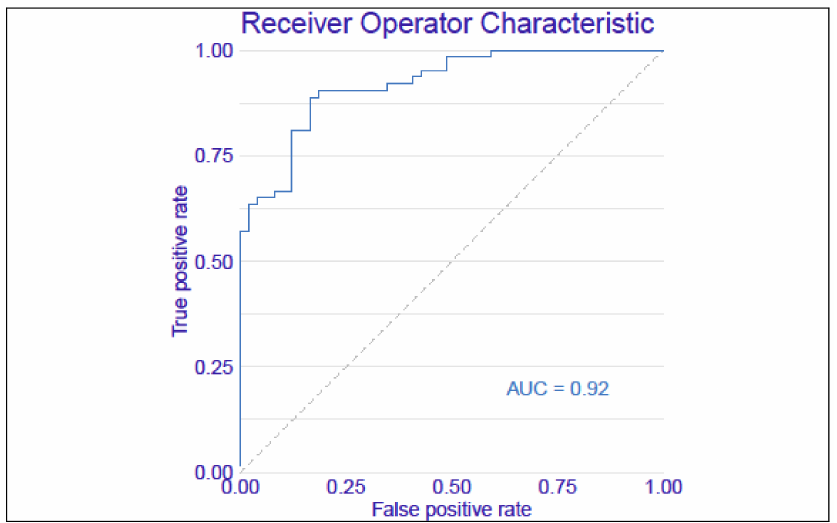
Figure 3. The ROC curve of the machine learning model for predicting the survival of sepsis. The following input variables were included in the model: pFN, the INR value, the APACHE II score, age, the SOFA score, the platelet count, the procalcitonin level, and the d-dimers